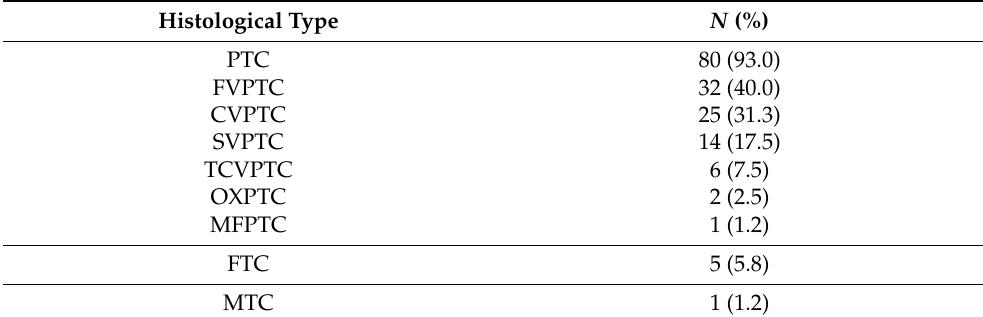
Table 3. Histotype of the malignant lesions found in coexistence with NIFTPs in 197 patients. MicroPTC have not been included in this table.